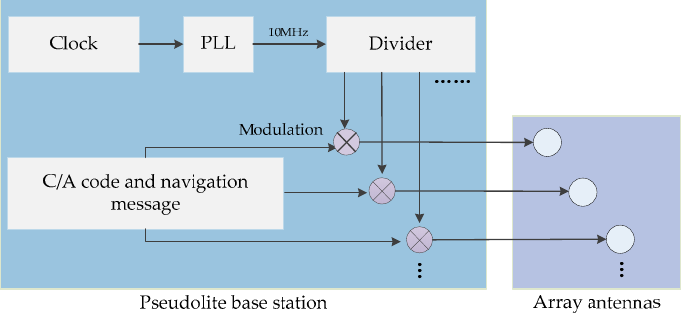
Figure 3. The principle of array pseudolite.